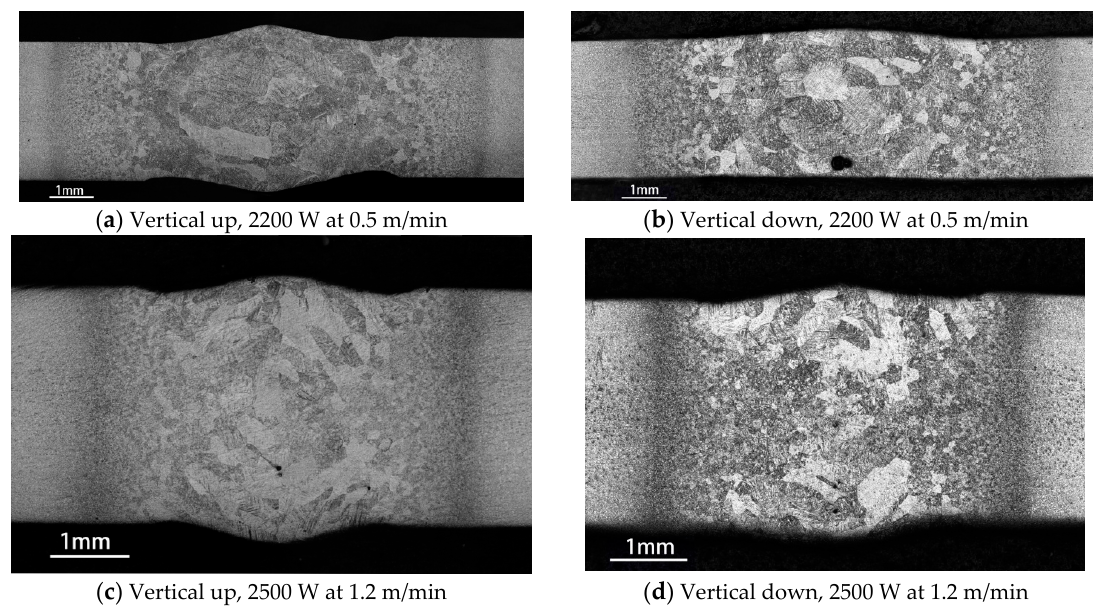
Figure 4. Laser bead shapes for different welding positions and process parameters.